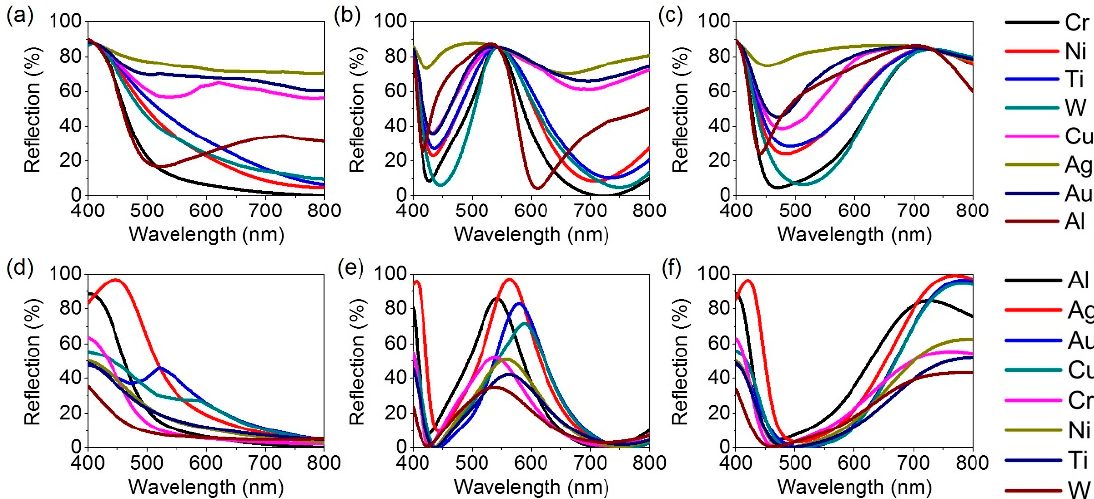
Figure 8. Calculated reflection spectra with different ( a – c ) top and ( d – f ) bottom metallic layers at normal incidence for blue, green and red colors.